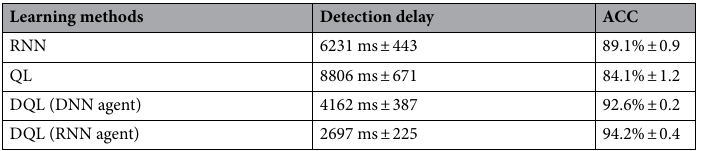
Table 2. The classification performance of the proposed SAAD system (in terms of detection delay and ACC) using four learning methods obtained for 60-s trials and 100 repetitions of the algorithm.